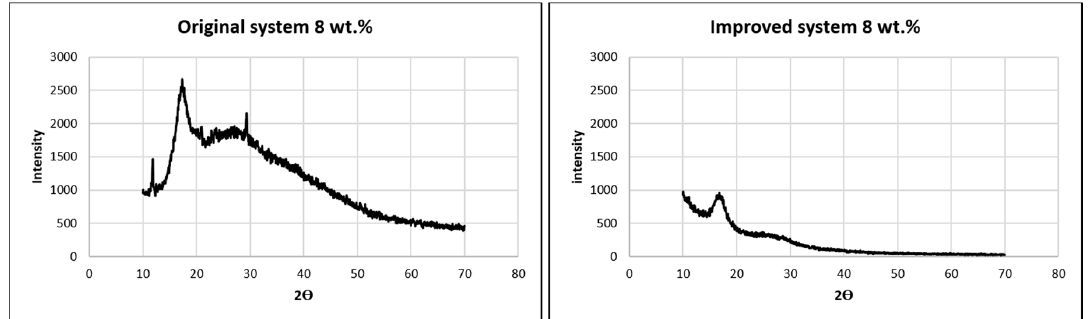
4800, as shown in Figure 17. The alignment of fibers was measured along the fiber direction. Figure 15. Intensity vs. 2 θ plot of XRD analysis of PAN at 8 wt.% for the original and improved systems. Figure 15. Intensity vs. 2 ϴ plot of XRD analysis of PAN at 8 wt.% for the original and improved systems.